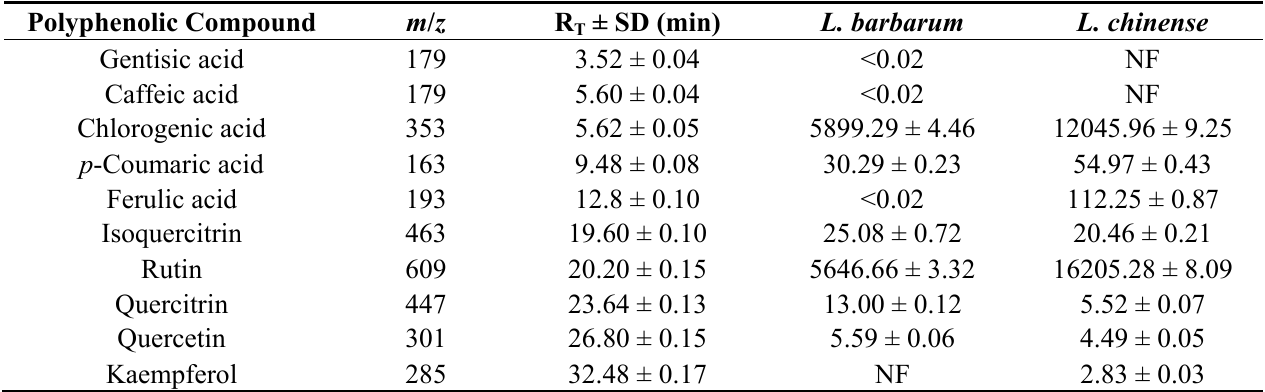
Table 1. The polyphenolic compounds content in the studied species ( μ g/g plant material). Polyphenolic